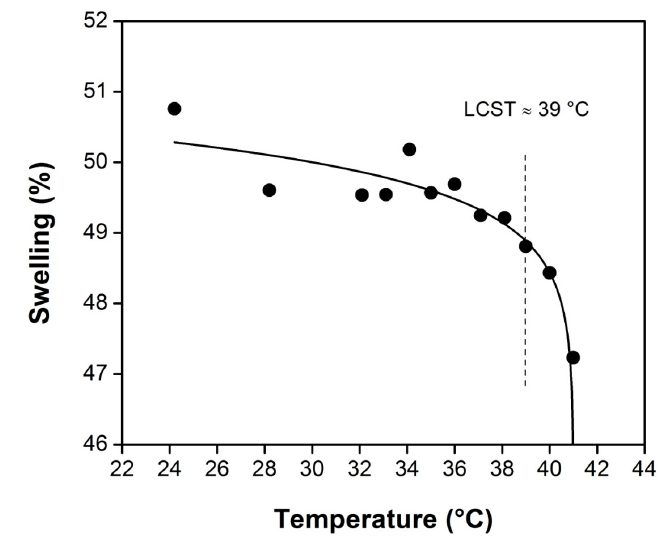
Figure 7. Temperature dependence of the swelling ratio in water as a function of temperature